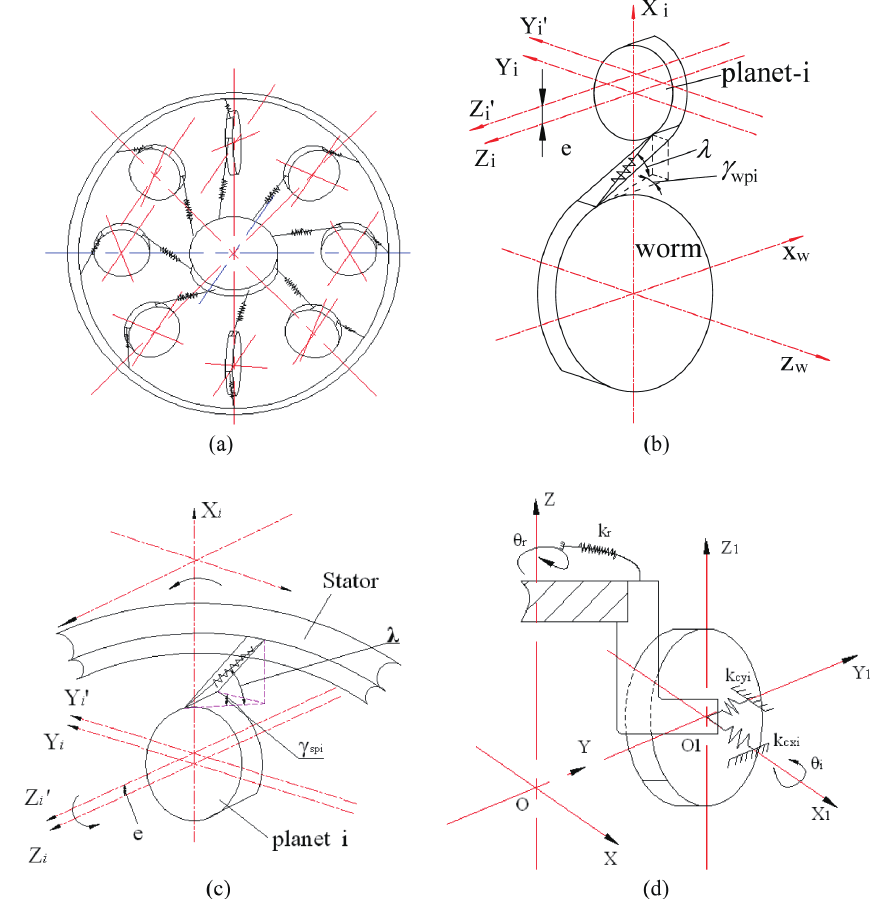
Fig. 3. Dynamic models of (a) a eight-planet toroidal drive, (b) a worm/planet pair, (c) a stator/planet pair, and (d) a rotor/planet